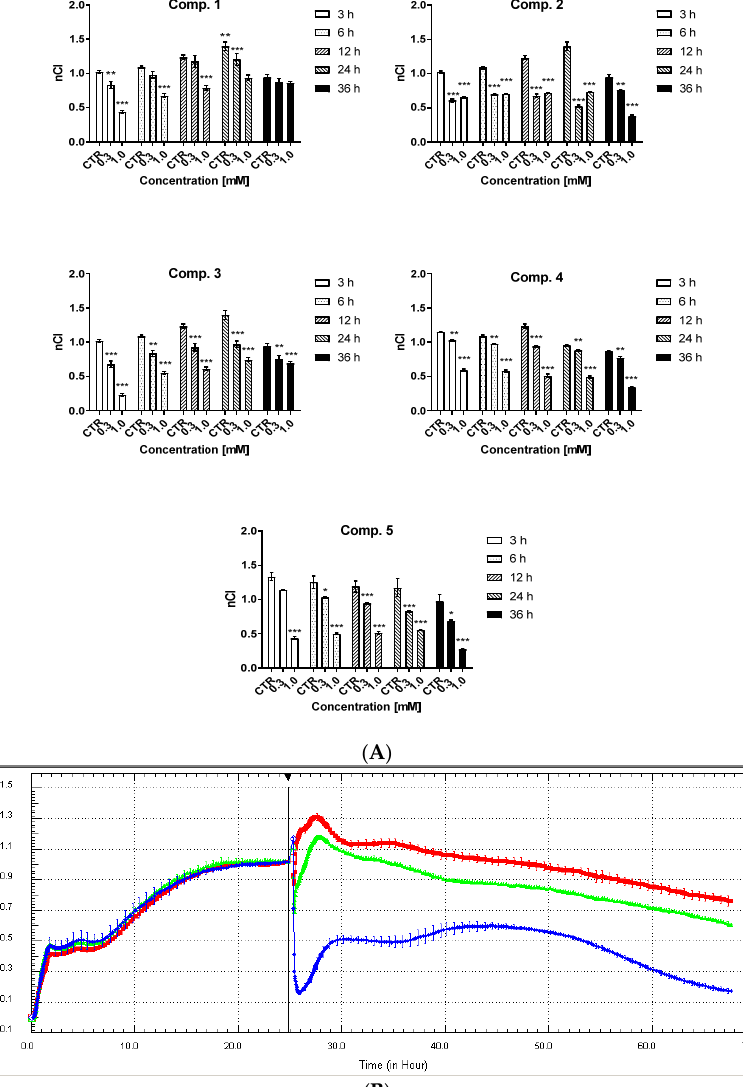
Figure 4. The effects of compounds 1 – 5 on the integrity of HUVEC analyzed in the RTCA-DP system. ( A ) The effect of the exposure of compounds 1 – 5 on normalized Cell Index (nCI) at selected time points (3, 6, 12, 24, and 36 h). The results are presented as mean ± SD, n = 4–5. An asterisk denotes a significant difference between sample treated with biguanide and control sample; * p < 0.05; ** p < 0.01; *** p < 0.001. ( B ) The effects of compound 5 on the barrier properties of HUVECs. The picture presents representative plots of one experiment conducted in duplicates (the results are presented as a mean (solid line) ± standard deviation). For the statistical analysis, three independent experiments were conducted. Red line—control (unstimulated cells); green line—compounds at the concentration of 0.3 mM; navy blue line—1.0 mM. Metformin was not found to affect the integrity and adherence of HUVEC cells over the entire concentration range (0.006–1.5 mM) in our previous study [28]. For instance,